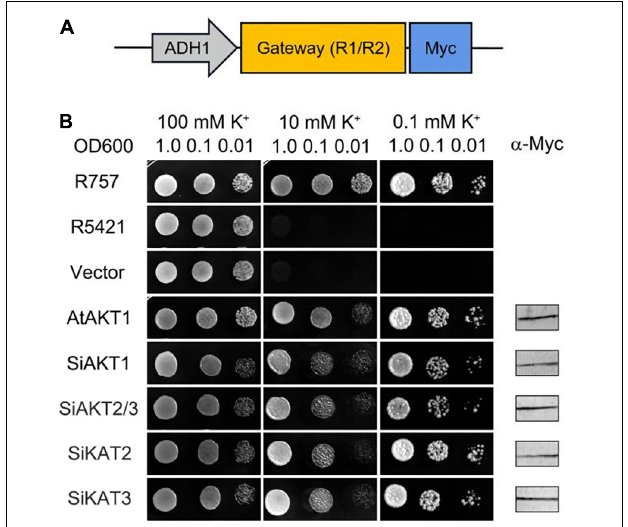
FIGURE 6 | Shaker K + channels from foxtail millet mediate K + Transport in Yeast. (A) Schematic of the padh1-Dest vector. (B) AtAKT1 and Shaker K + channels from foxtail millet complement the K + uptake-deficient yeast mutant R5421. The yeast strain R757 was used as a control. Immunoblot analysis (5 µ g total protein/lane) of yeast was performed using a commercial α -Myc